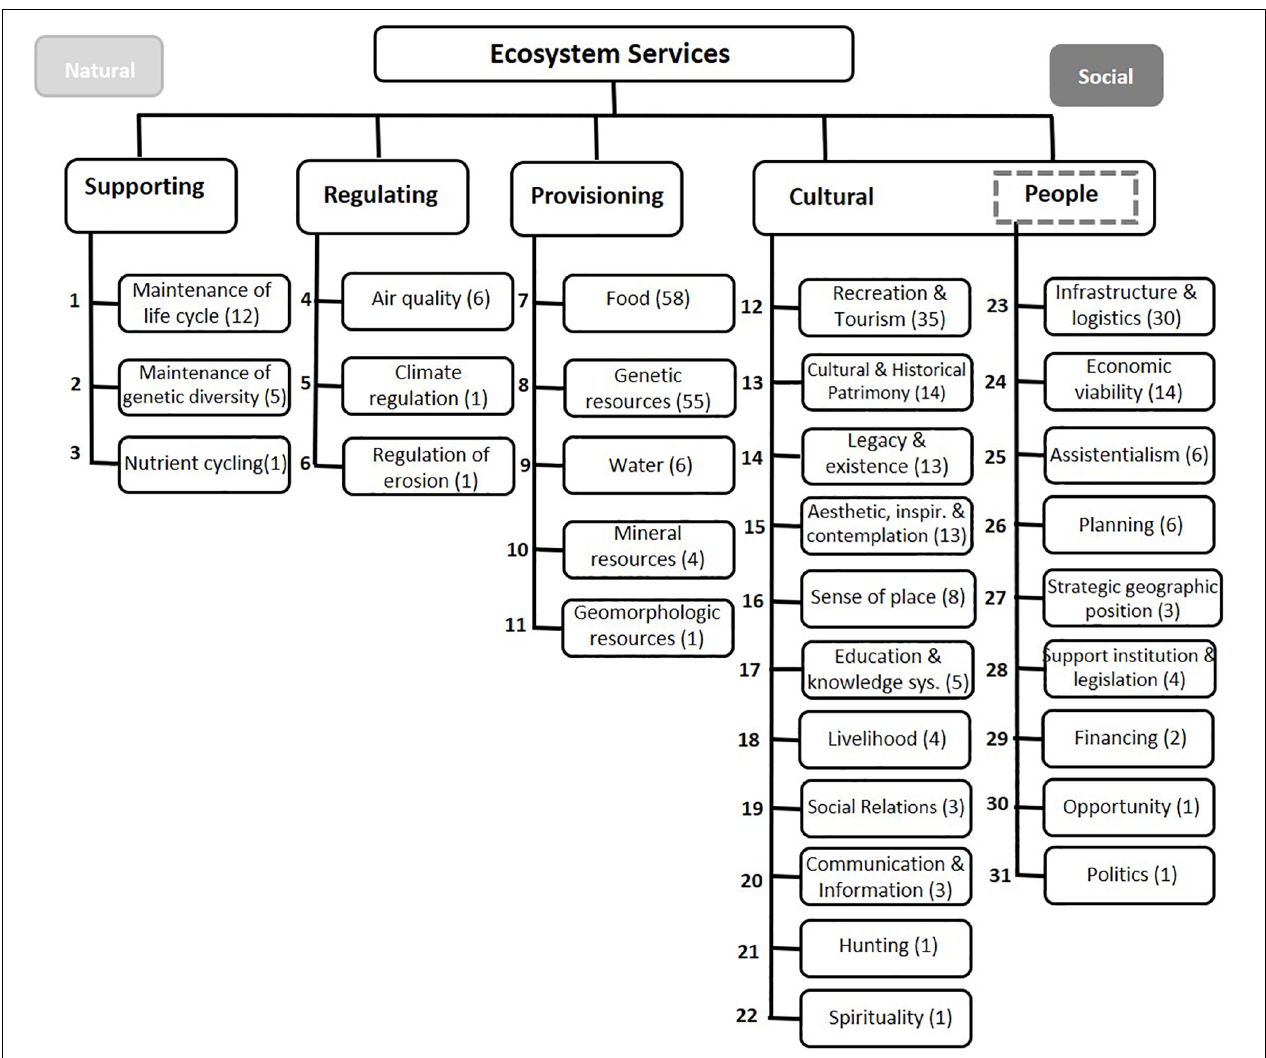
FIGURE 4 | Adaptation of Raymond et al. (2009) ES’ framework to a social-ecological systems perspective, considering the types of services in a socioecological system gradient, ranging from more natural (supporting, regulating, and provisioning), and social (cultural and people) properties to a main point of connection and interconnection of these characteristics represented by cultural services. We considered 31 subtypes and 317